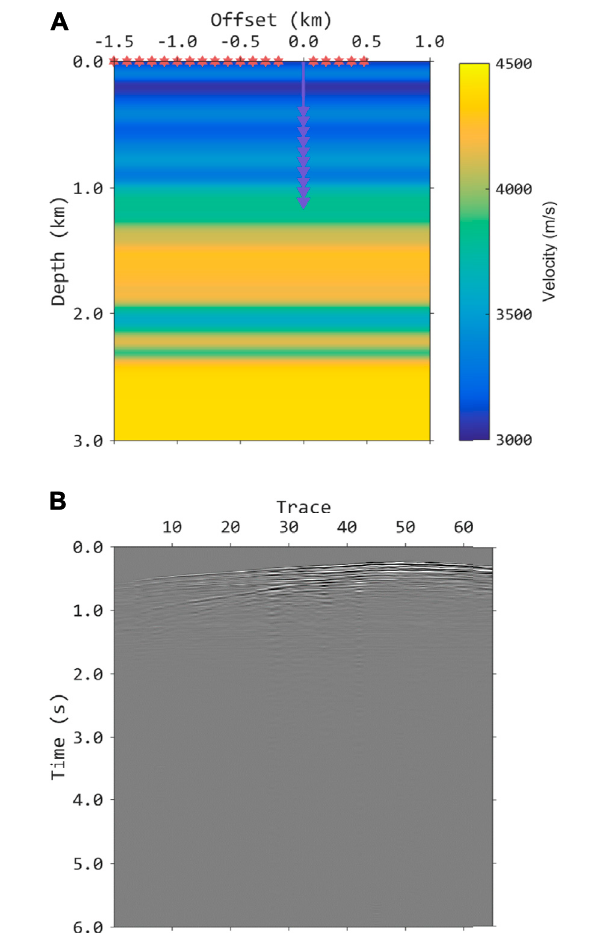
FIGURE 9 | (A) The migration velocity and walkaway VSP acquisition used in fi eld application. (B) The common receiver gathers obtained from the data containing multiples. Note that several near-offset traces are missing.